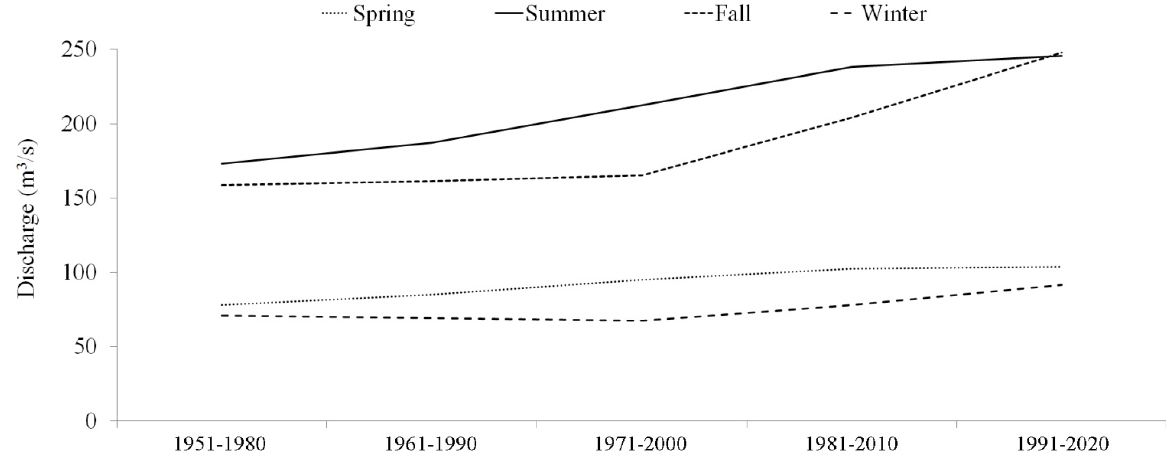
Figure 8. Average seasonal discharge from 1951 to 1980 period to 1991–2020